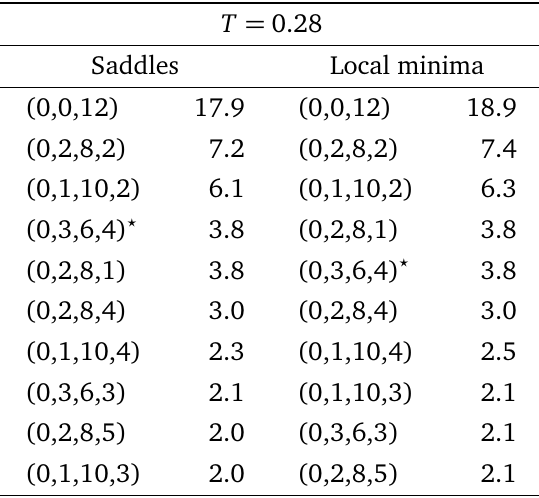
Table 2: Percentage of most frequent Voronoi signatures in saddles and local minima sampled at T = 0.28. The (cid:63) symbol denotes the signature with the largest occurrence for core particles.